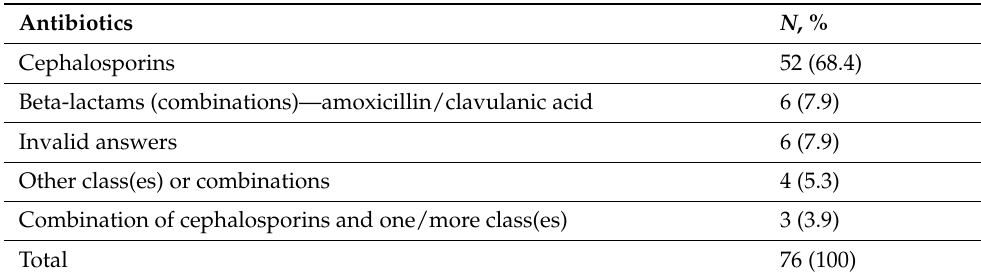
Table 8. Oral antibiotics at discharge—complicated